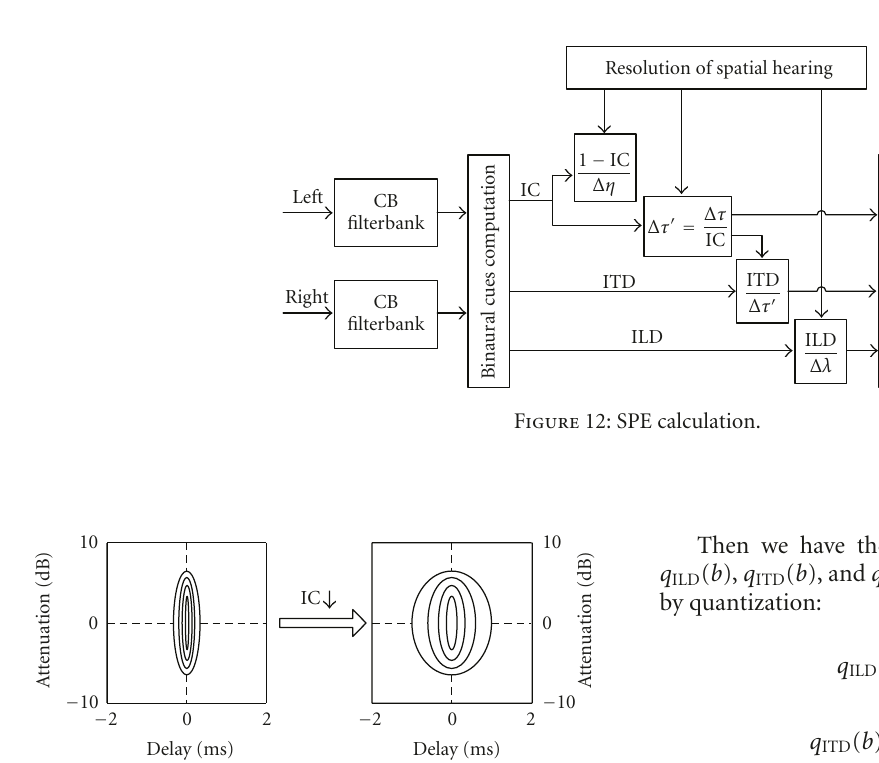
Figure 13: The di ff erent e ff ects of IC on ITD and ILD